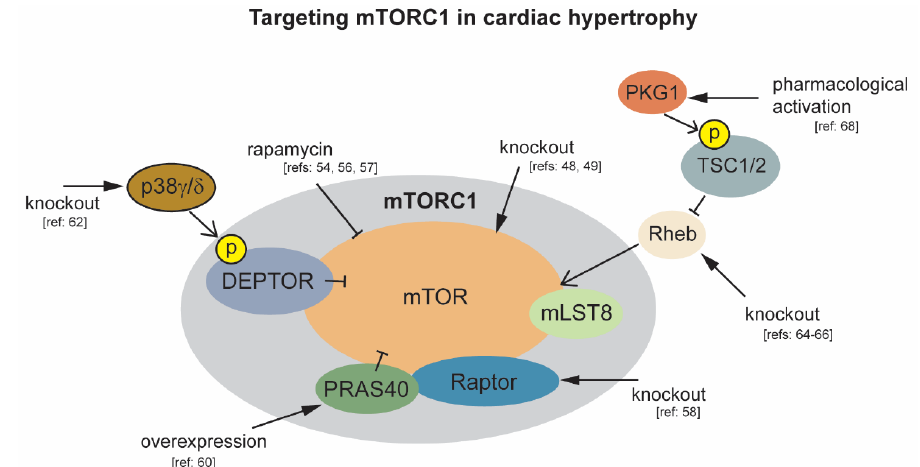
Figure 1. Modulation of mTORC1 activity to protect against cardiac hypertrophy. Black arrowheads indicate experimental interventions targeting mTORC1 and its regulatory components.